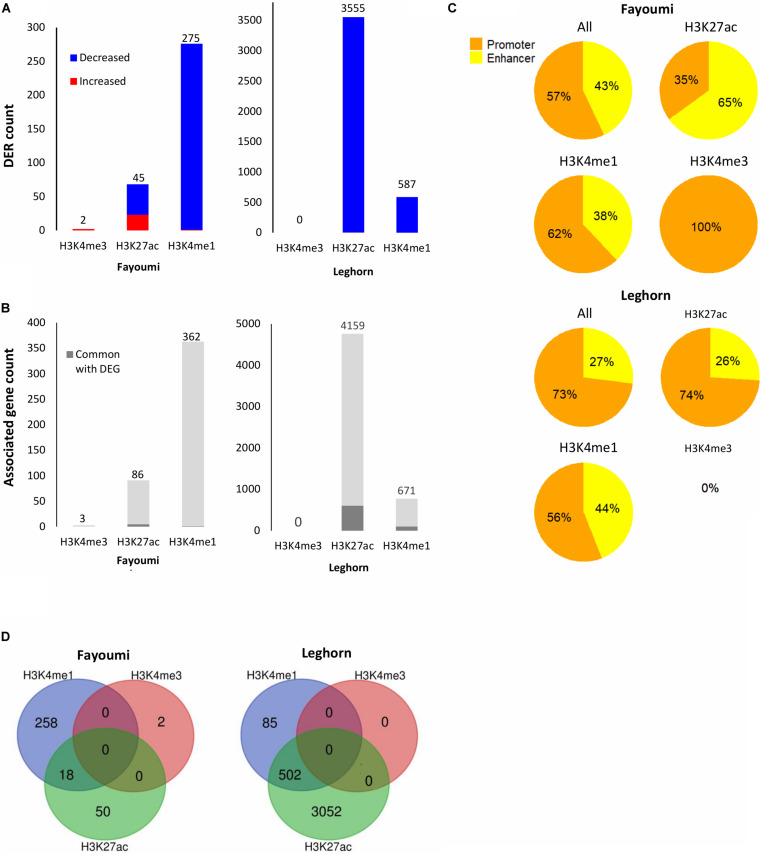
Summary of DER analysis for within-line comparisons. (A) Stacked bar plots showing the number of DERs with increased or decreased enrichment identified for each within-line comparison across all histone modifications. (B) Stacked bar plots showing the number of unique target genes associated with DERs and the number of associated genes that are in common with DEGs of the corresponding differential gene analysis (i.e., within-line Leghorn or Fayoumi). (C) Pie charts showing the percentage of promoters or enhancers within the DERs of each histone modification. (D) Venn diagrams showing overlap of DERs across histone modifications. No overlap of H3K4me3 DERs was found for either comparison.